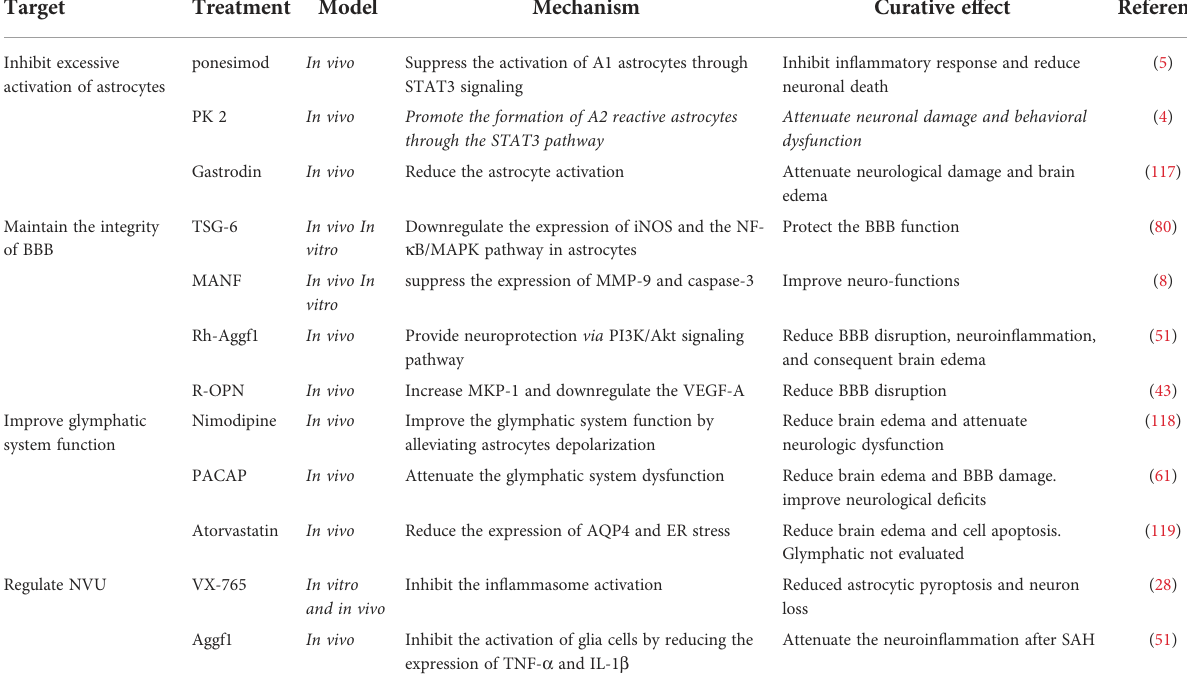
TABLE 1 Treatments targeting astrocytes for SAH, their potential mechanisms, and curative